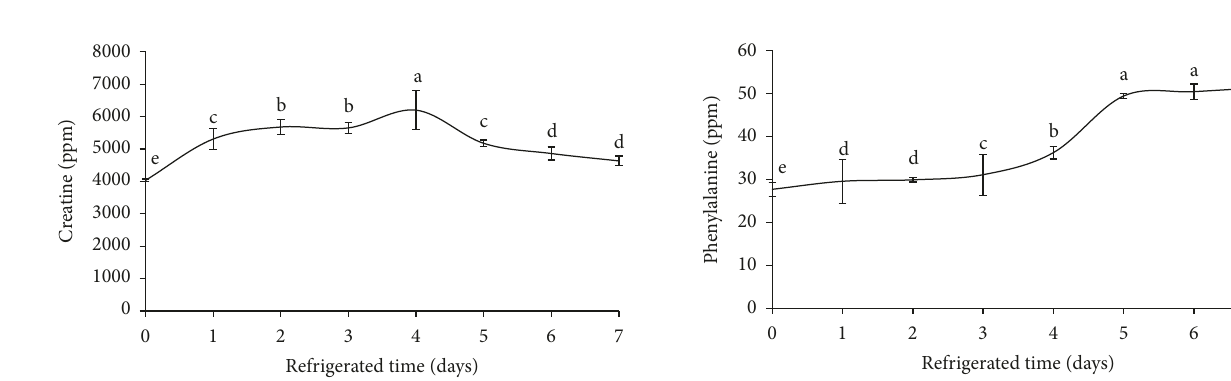
Figure 7: Phenylalanine concentration of biofluids at 4 ∘ C for 7 days. Values are means ± SD ( n = 3). Different superscript letters indicate significant differences ( 𝑝 < 0.05